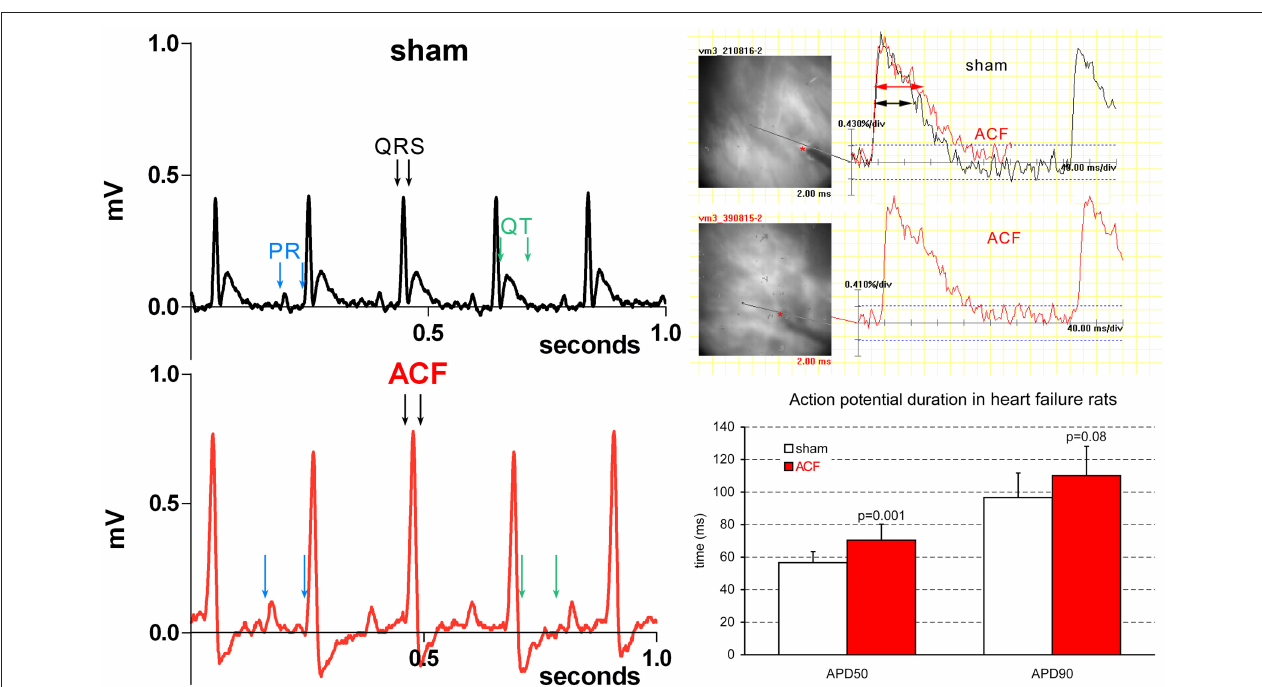
FIGURE 1 | Representative ECG and EP recordings highlighting the changes in quantitative parameters. Note an increased P wave amplitude and duration, increased R amplitude, and prolonged QRS duration in a typical ACF recording. Prolongation of APD50 (right column) is present in the ACF group as whole (compare with the sub-group values in Table 1